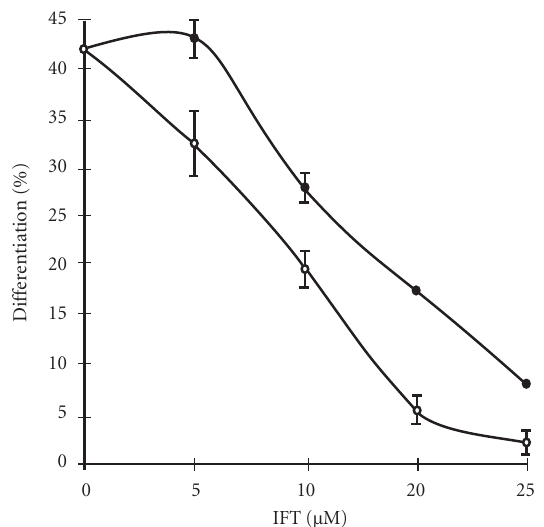
Figure 3: Effect of farnesyltransferase inhibitors on differentiation of HL-60 cells by ATRA. HL-60 cells were pretreated with increasing concentrations of FTI-II ( • ) or FTI-277 ( ◦ ). After 24hours, The ATRA (1 µ M) was added to culture medium. Cell differentiation was determined at day 4.